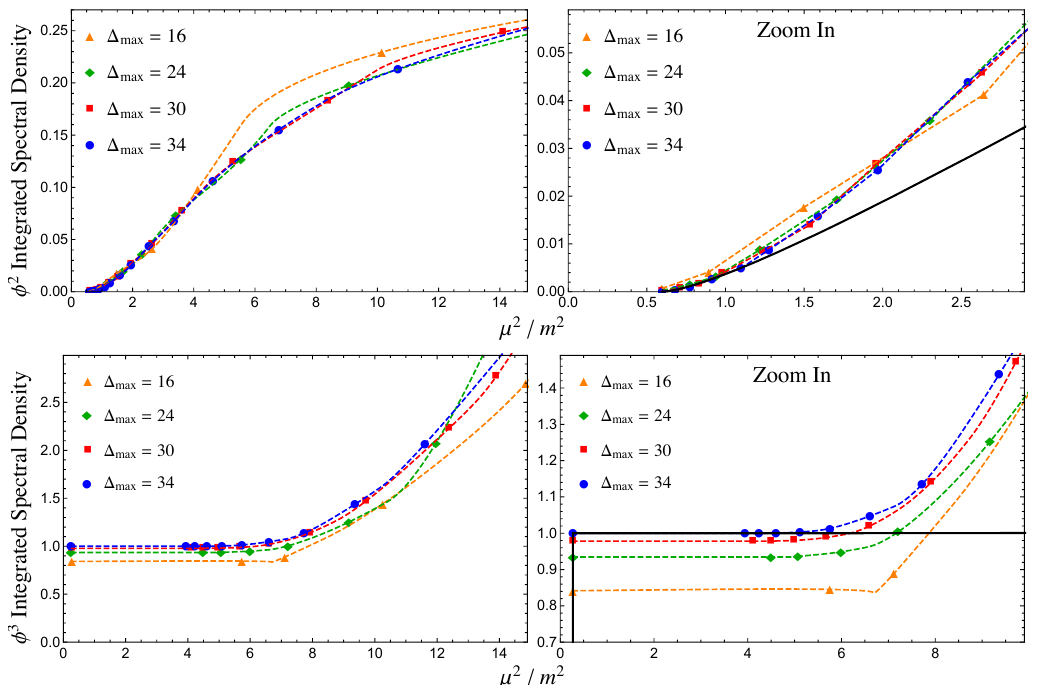
Figure 8 . Integrated spectral densities for (cid:30) 2 (top) and (cid:30) 3 (bottom) at di(cid:11)erent values of (cid:1) max . The (cid:1) max = 34 results (blue dots) are at (cid:22) (cid:21) = 1 : 96 (top) and (cid:22) (cid:21) = 1 : 69 (bottom), and the 4 (cid:25) 4 (cid:25) couplings for the remaining results have been chosen such that the respective mass gaps remain (cid:12)xed. The points are the actual contributions of individual eigenstates to the spectral density, while the dashed lines are interpolations. The right plots are simply a zoomed-in version of the left ones, and compare the conformal truncation results to the theoretical IR predictions for " (top) and (cid:27) (bottom) in the Ising model.